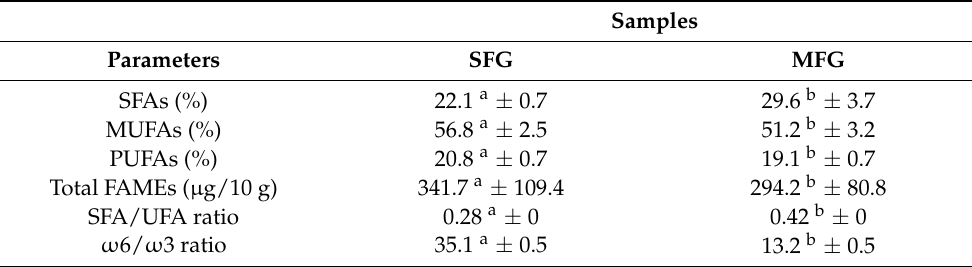
Table 5. Fatty acid quality indicators of SFG and